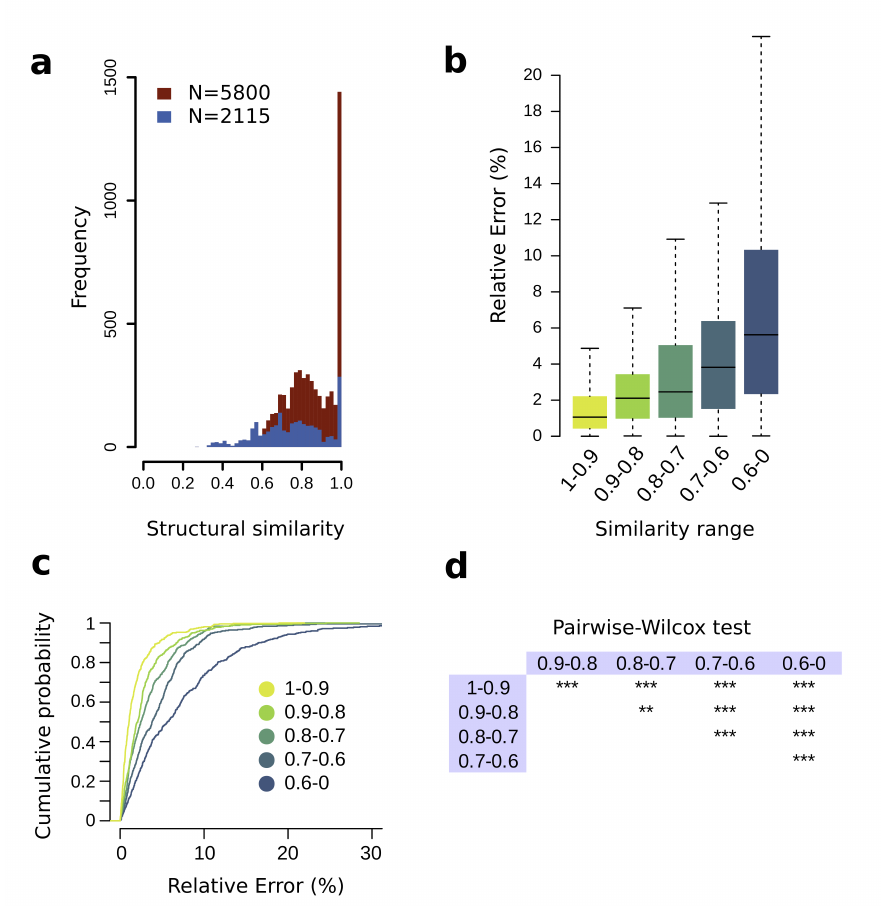
Figure 3. Structural similarity influence. ( a ) Distribution of Tanimoto similarity of the full training set (red) and randomly selected metabolites (blue). ( b ) Prediction error across similarity ranges. ( c ) Cu- mulative probability functions (CPF) for the structural similarity ranges. ( d ) Statistical significance for pairwise comparisons in ( b ): Wilcoxon test, *** for p -value < 0.001; ** for p -value <